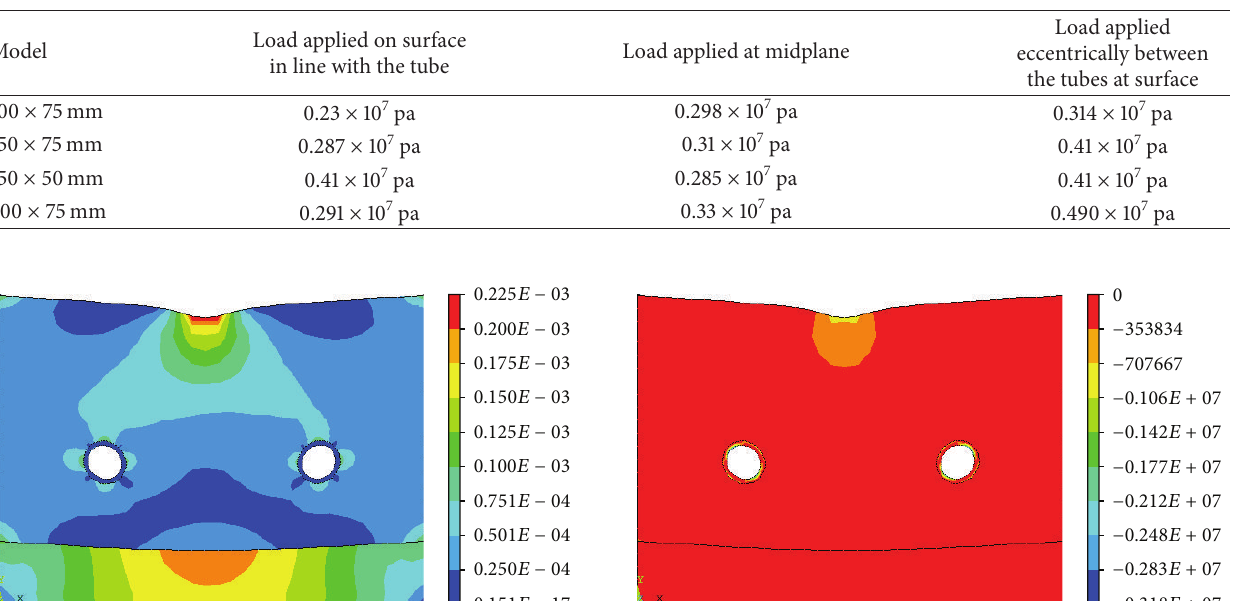
Table 6: Result of stress analysis.